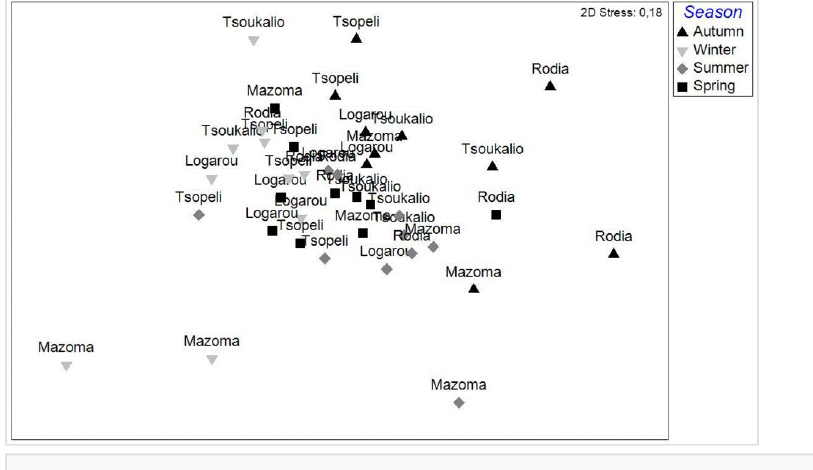
nMDS analysis plot between the stations based on the abiotic data from all the lagoons and sampling seasons.